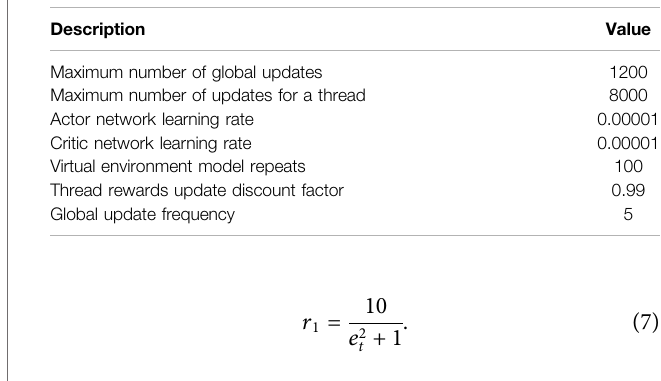
TABLE 1 | Parameters of the actor network and critic